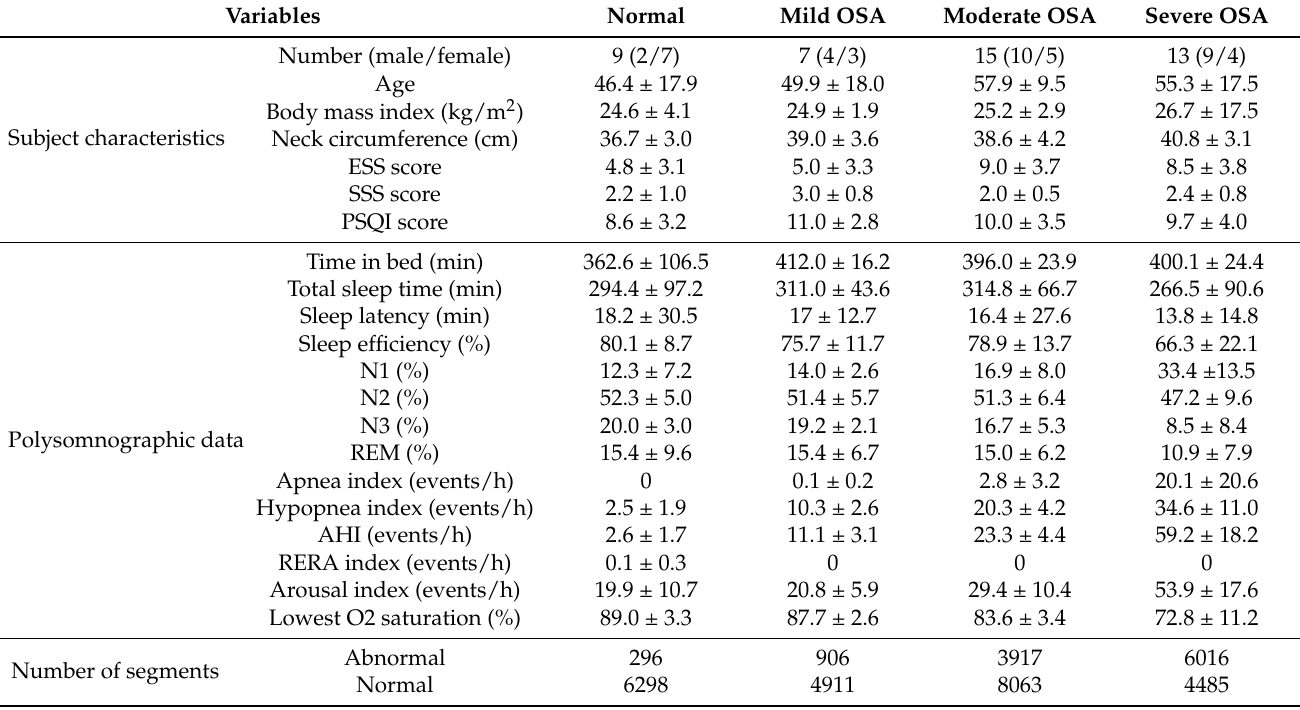
Table 1. Demographic and polysomnographic data of the study